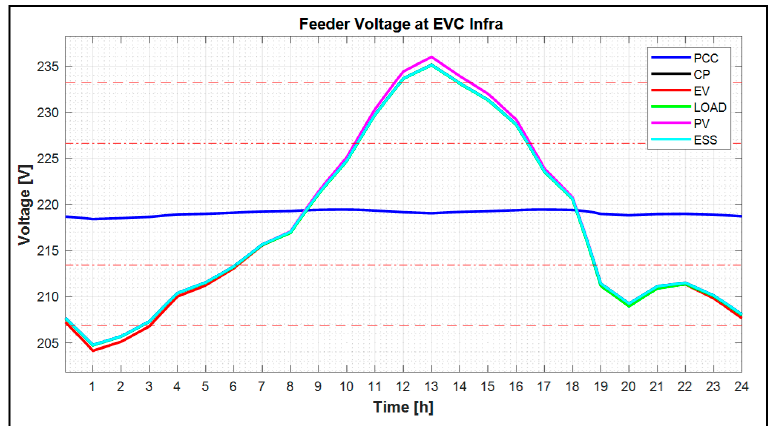
Figure 21. Analysis of the feeder voltage characteristic at electric vehicle charging (EVC) infrastructure without an ESS.